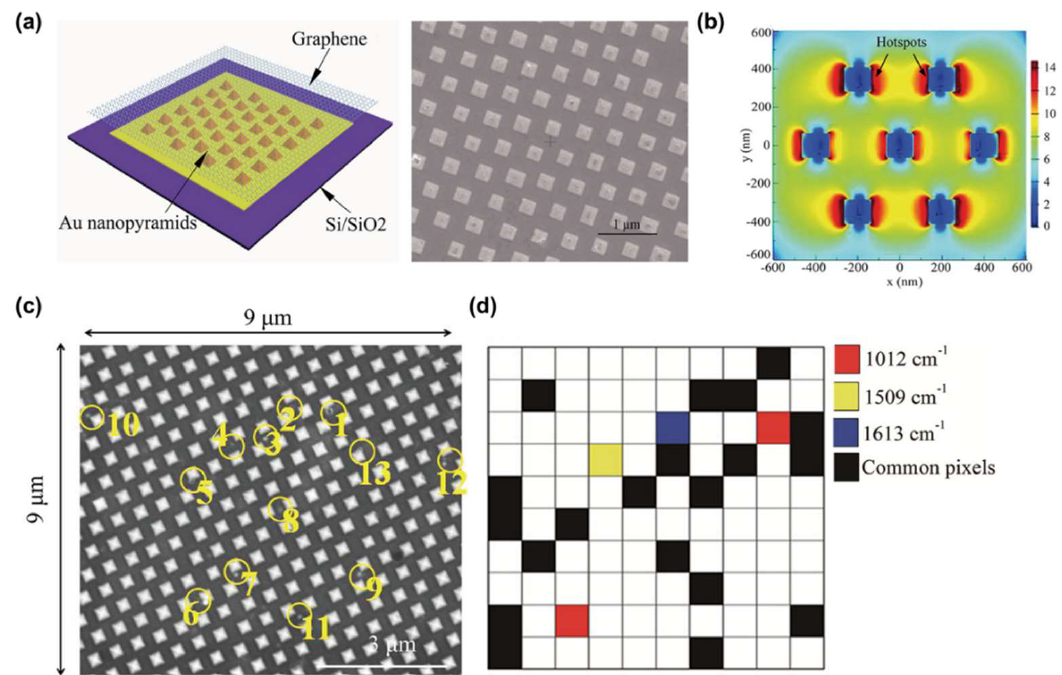
Figure 4. Hybrid SERS substrate-based EVs detection. ( a ) The schematic illustration and SEM image of the hybrid SERS substrate. ( b ) The EM field distribution result was calculated using a finite- difference time-domain (FDTD) simulation. ( c ) SEM image of EVs attached to the hybrid SERS substrate. The yellow circles represented attached EVs within this area. ( d ) Mapping result using SERS peak of EVs. The red, yellow, and blue represent 1012, 1509, and 1613 cm –1 peaks in the Raman spectrum. The black pixels indicate points where all three Raman bands were detected and were regarded as containing EVs. Adapted with permission from Ref [51]. Copyright 2019 American Chemical Society.